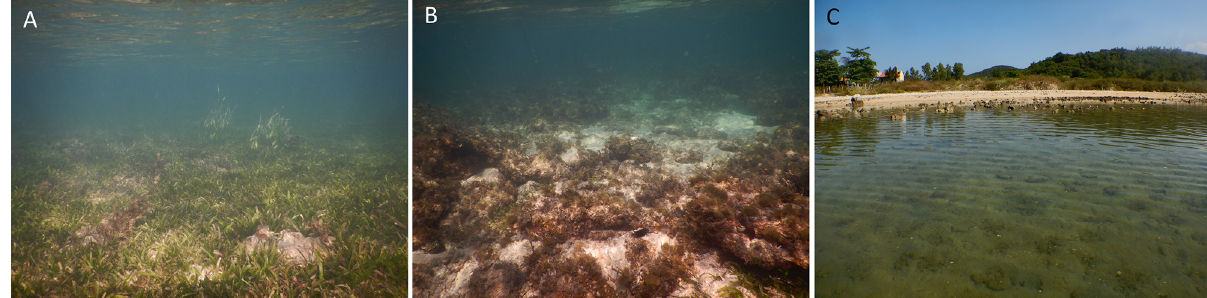
Fig. 4. Different shallow substrata at MG. See Figure 3 for the abbreviation of locations. Sea Figure 3 for the kinds of